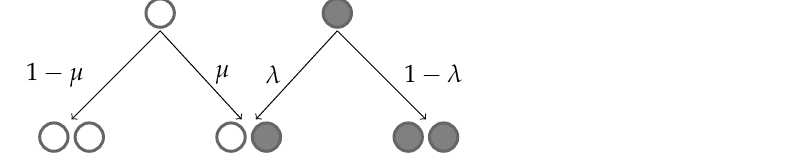
Figure 1. White balls in the diagram represent sensitive cells, while black balls represent resistant cells. Arrows pointing from the top tier balls (mother cells) downwards illustrate the four possible outcomes of cell division: ( left ) Either a sensitive parent cell has a sensitive descendant or its offspring is resistant with probabilities 1 − µ and µ , respectively; ( right ) a resistant cell may produce a sensitive or resistant offspring with probabilities λ and 1 − λ , respectively.